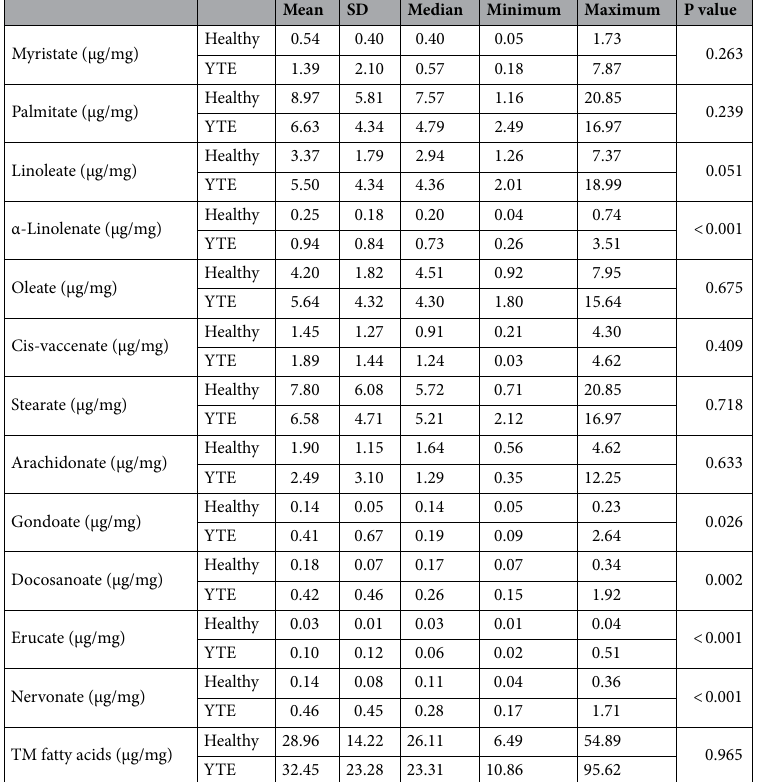
Table 4. Summary statistics of fecal fatty acid concentrations in YTE dogs and healthy control dogs. TM, total measured; YTE, Yorkshire Terrier enteropathy; SD, standard